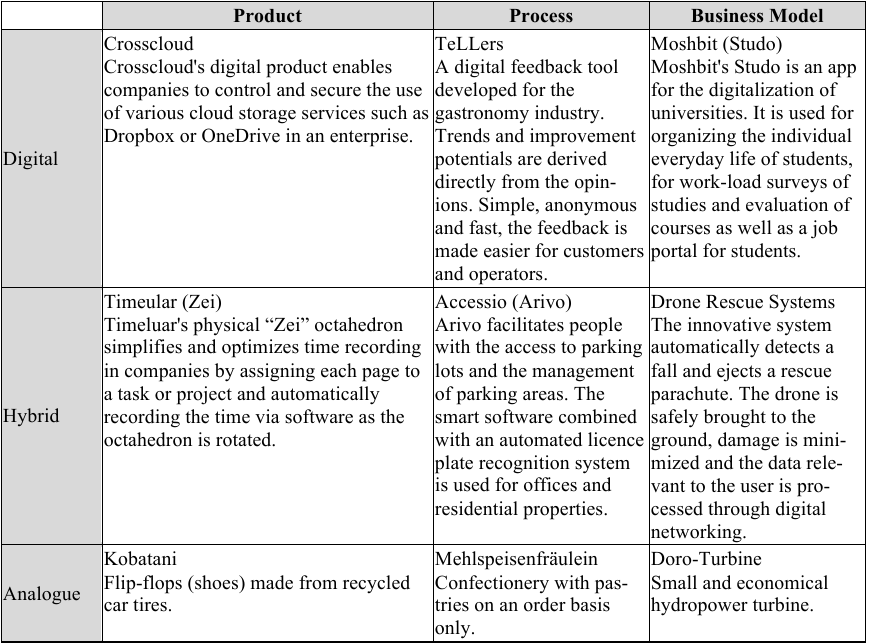
Table 1. Classification of nine examples of start-up projects into the levels of digitalization Product